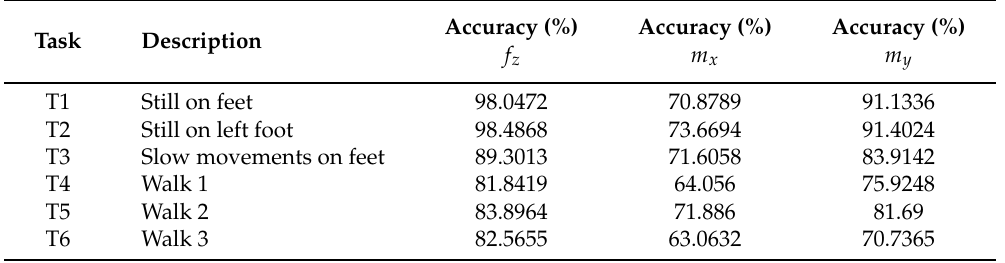
Table 2. Tracking accuracy of vertical ground reaction force f z and horizontal moments m x , m y , respectively, from tasks T1 to